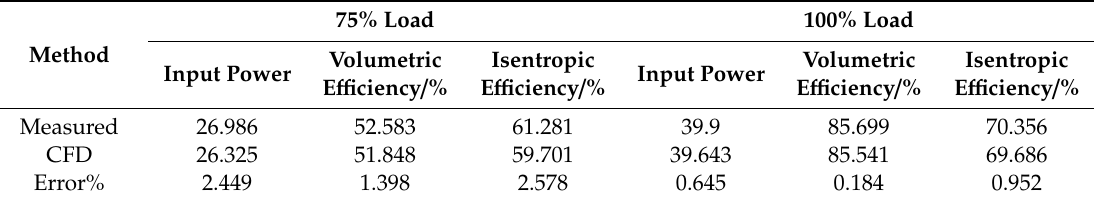
Table 4. Comparison of the macroscopic performance of the compressor under two working conditions.